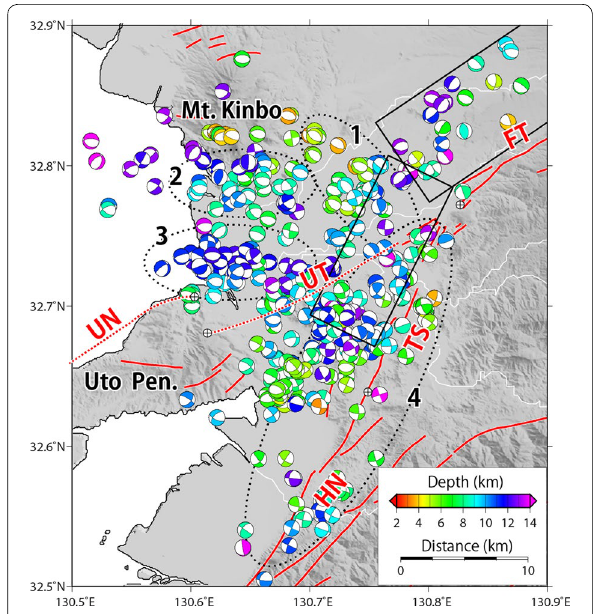
Fig. 4 Focal mechanism solutions using the P-wave first-motion polarity (lower hemisphere projection). The beachballs are color-coded according to hypocenter depth. The solid rectangles represent the surface projection of the source fault planes for the mainshock in Asano and Iwata (2016). The solid and dashed red lines denote the active faults determined by RGAF (1991) and HERP (2013), respectively. FT Futagawa segment, UT Uto segment, UN north coast of Uto Peninsula segment, TS Takano–Shirahata segment, HN Hinagu segment. Ellipses approximate the areas of each focal mechanism solution group classified by location and